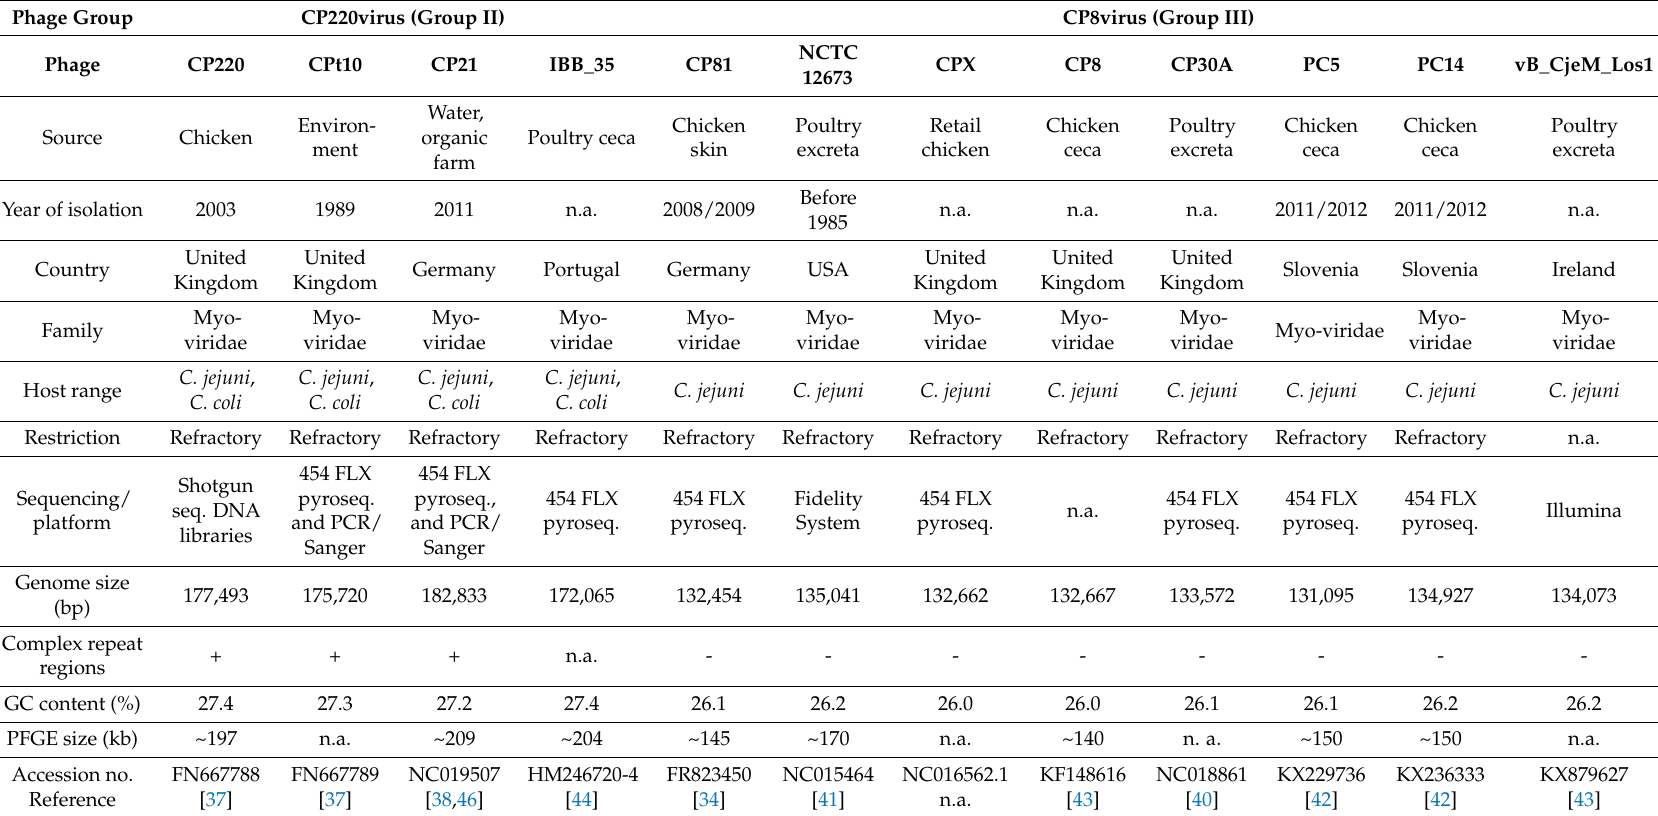
Table 1. Some characteristics of hitherto sequenced Campylobacter